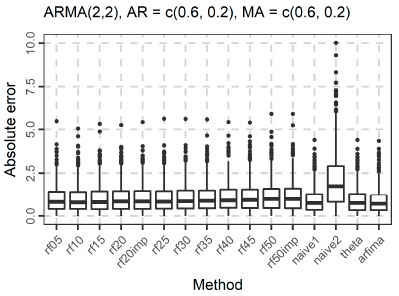
Figure 5. Boxplots of the absolute errors when forecasting the 101st value of 1000 simulated time series from each ARMA( p , q ) model used in the present study.